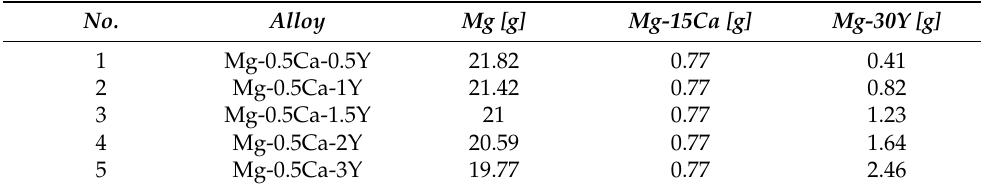
Table 1. Load calculation for the 5 experimentally designed alloys